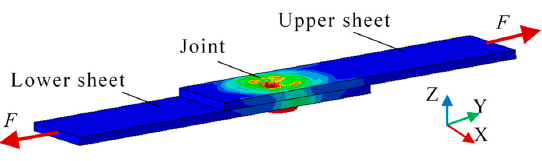
Figure 7. Shearing test on joint by simulation.